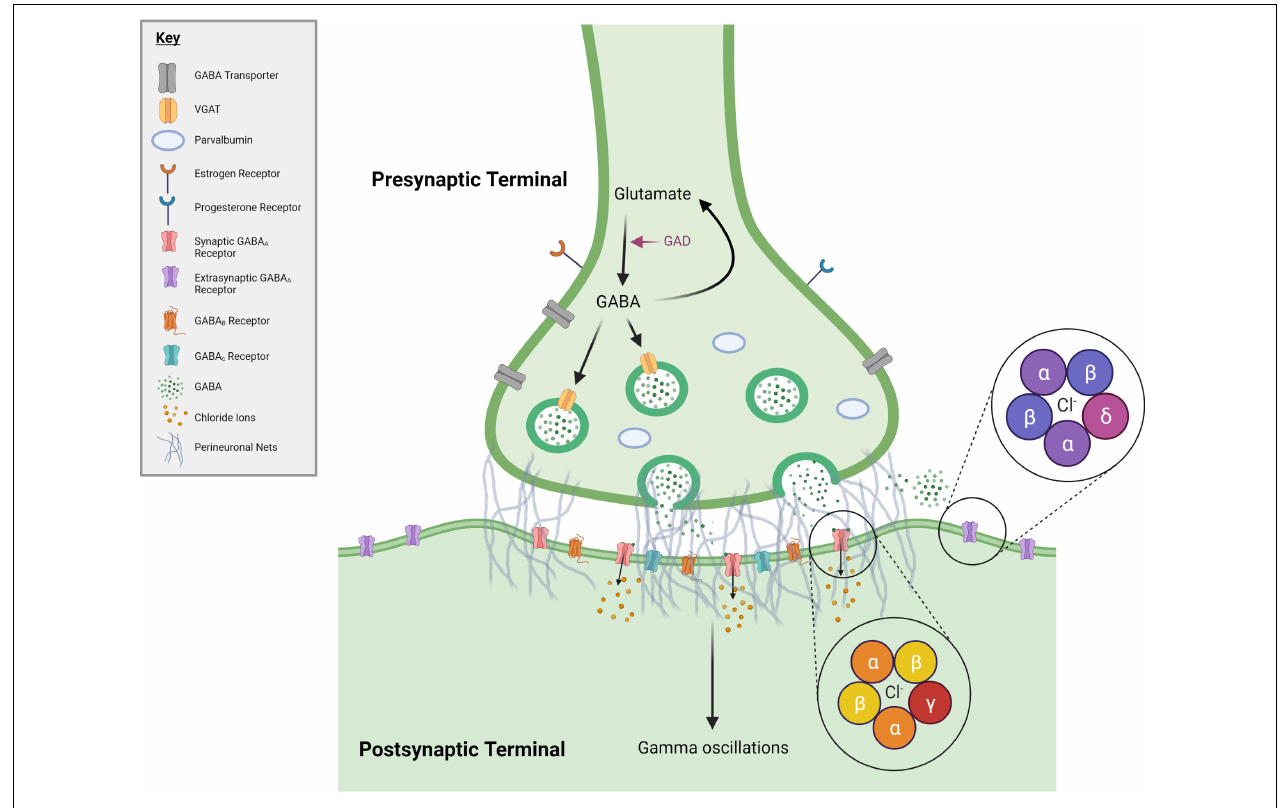
FIGURE 1 | GABAergic synapse. During periods of hormonal flux across the female lifespan, numerous changes to the GABA system occur. Many of these changes occur within GABA synapses, represented here. Included in this figure are the elements of the GABA system discussed in this manuscript. Pink text denotes an enzyme. GABA = gamma-Aminobutyric acid, GAD = glutamate decarboxylase, VGAT = vesicular GABA transporter. Created with